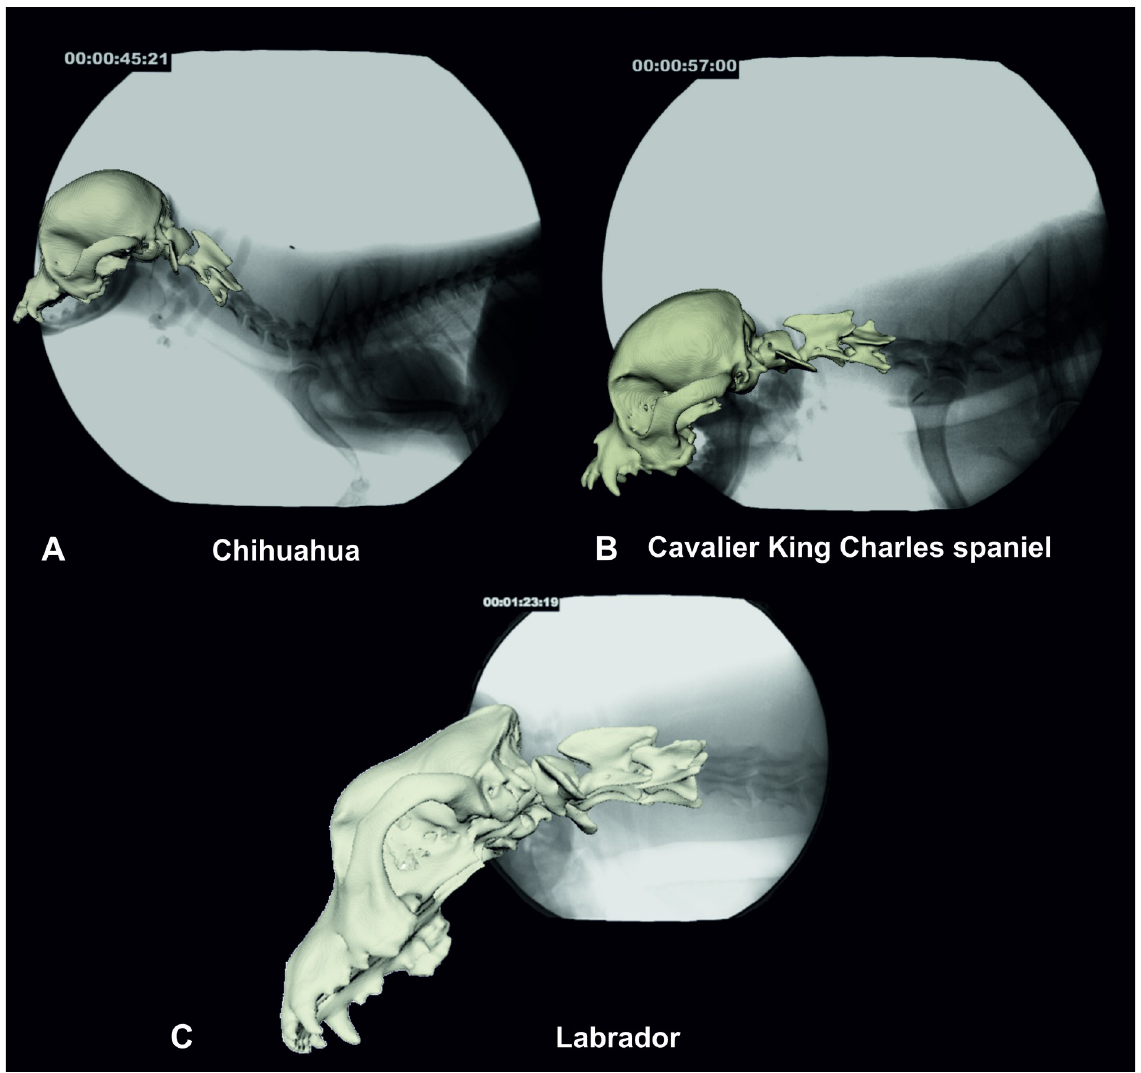
Fig 11. Comparative fluoroscopy images with superimposed bone model of a Chihuahua (A), a CKCS (B) and a Labrador retriever (C). The CKCS and Labrador retriever show a straight neck position in alignment with the withers while the Chihuahua shows an upright neck position and accordingly a steeper atlas angle. Images A and B: 90˚ camera position, image C: 63˚ oblique camera